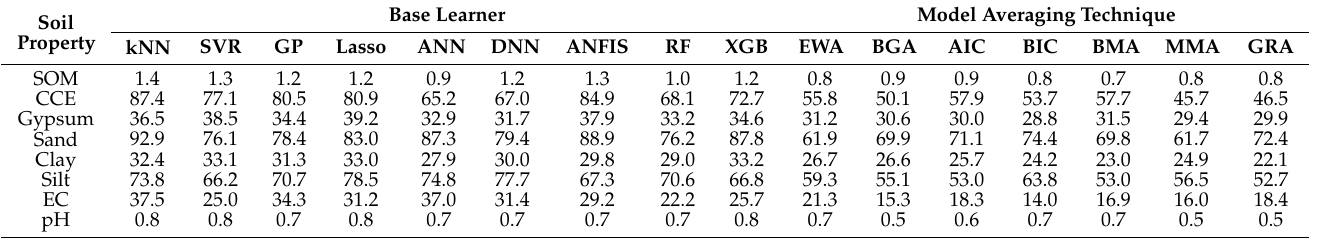
Table 5. Uncertainty of the models for predicting soil properties (mean prediction interval;